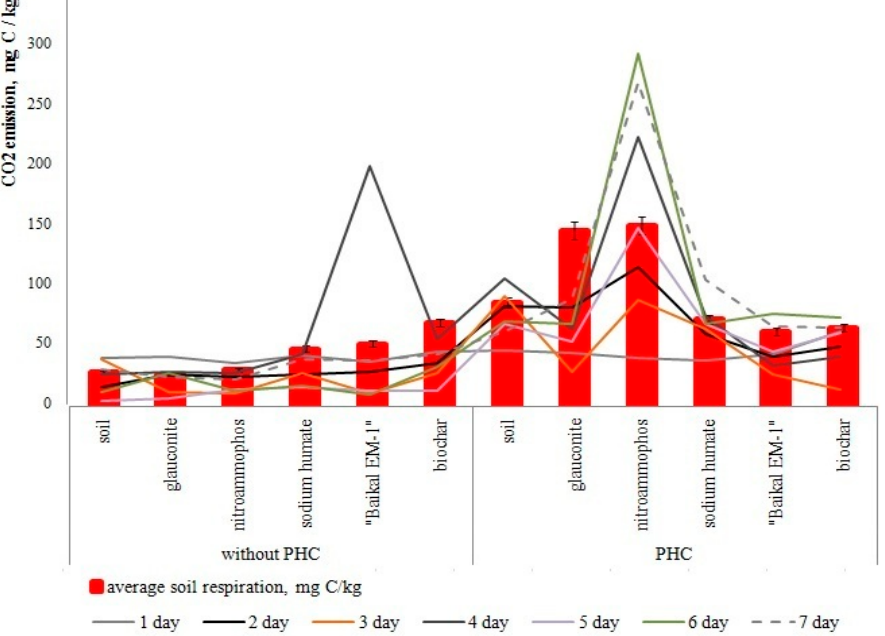
Figure 10. Change in soil respiration (CO 2 emission) in non-contaminated and petroleum hydrocarbon-contaminated Haplic Chernozem Calcic after adding various bioremediators for 30 days, mg C·kg − 1.